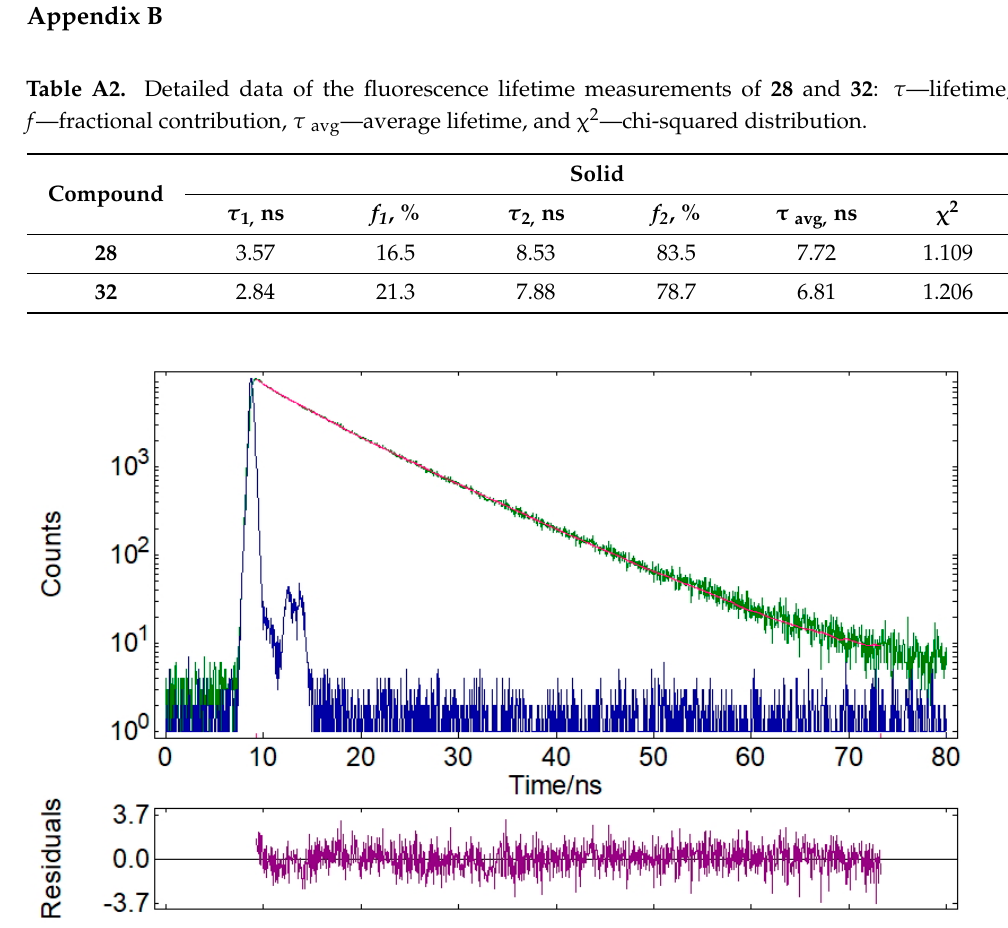
Figure A1. Time − resolved fluorescence lifetime decay profile of solid powder 28 (green) and instru- mental response function (IRF, blue). λ ex = 375 nm and λ em = 504 nm.